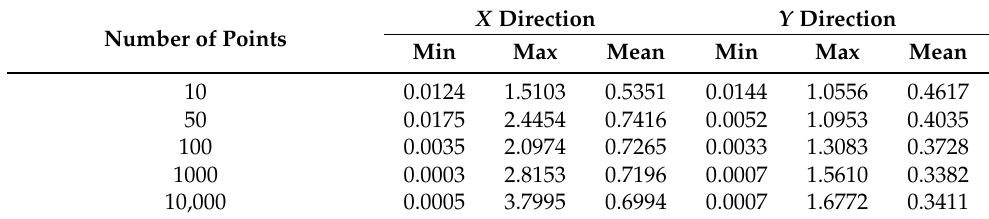
Table 4. Number of points and calibration